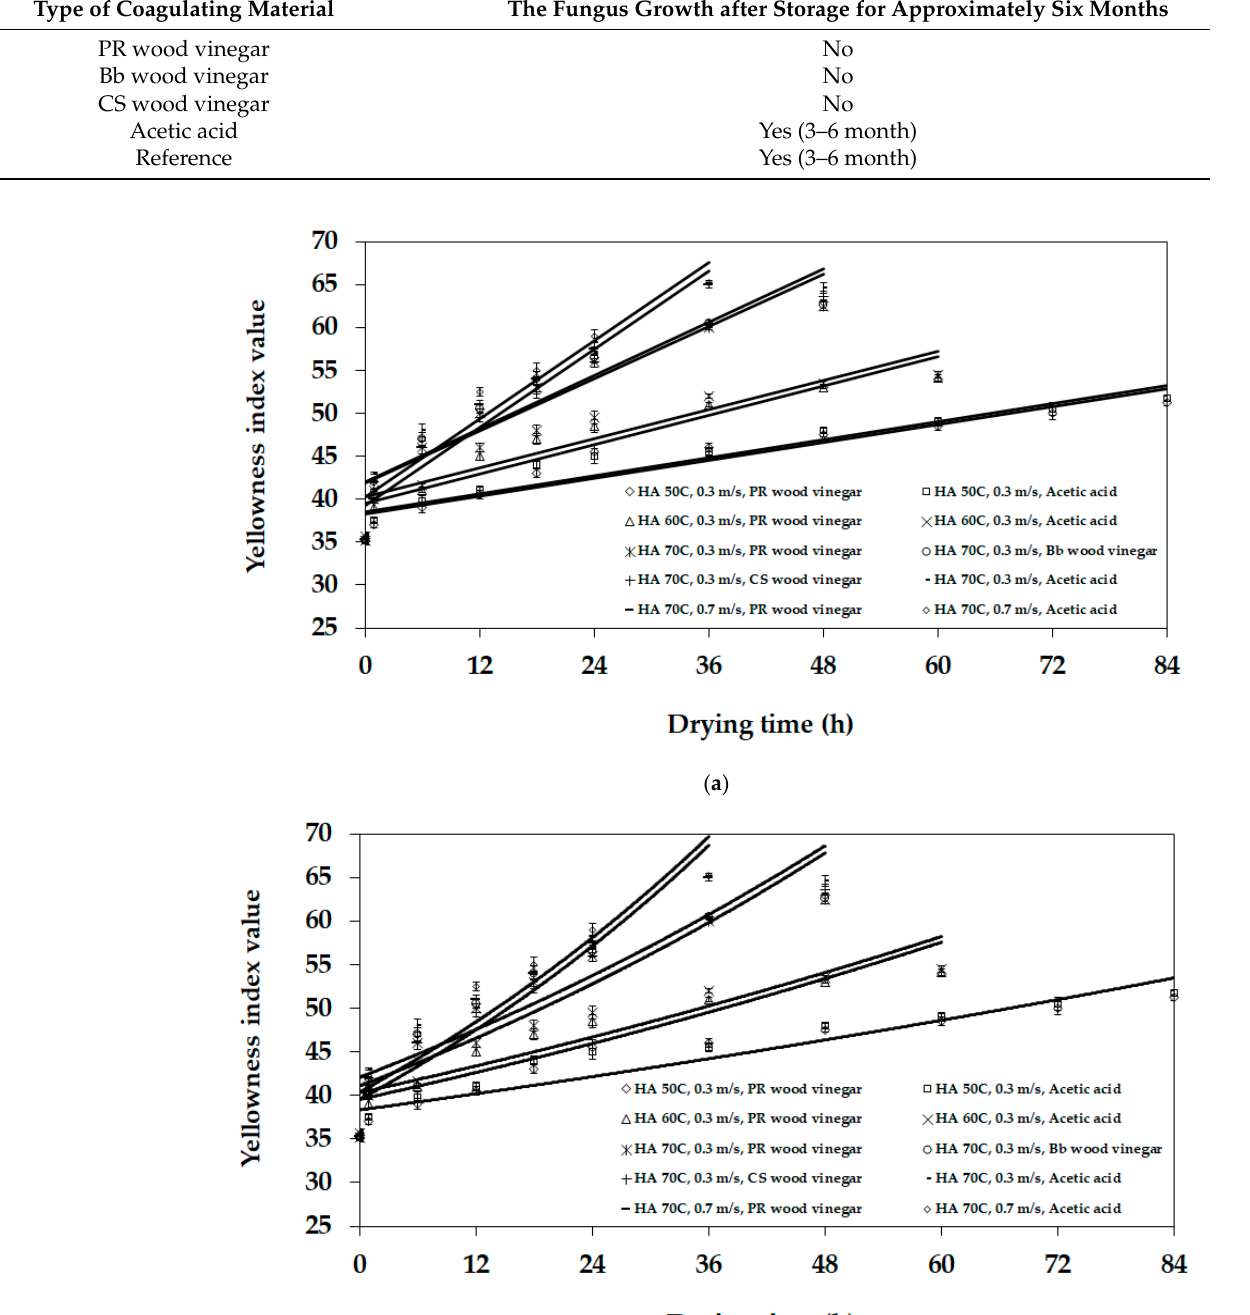
Table 4. The fungus growth on the surface area of the dried sheet product after storage (PR = para rubber, Bb = bamboo, and CS = coconut shell).